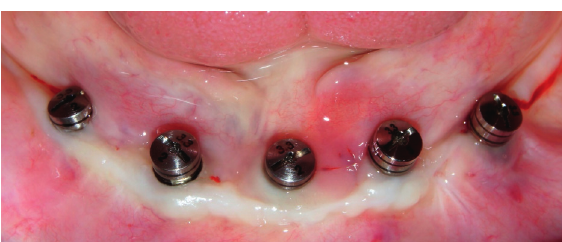
Figure 11: Tissue stabilization at 6